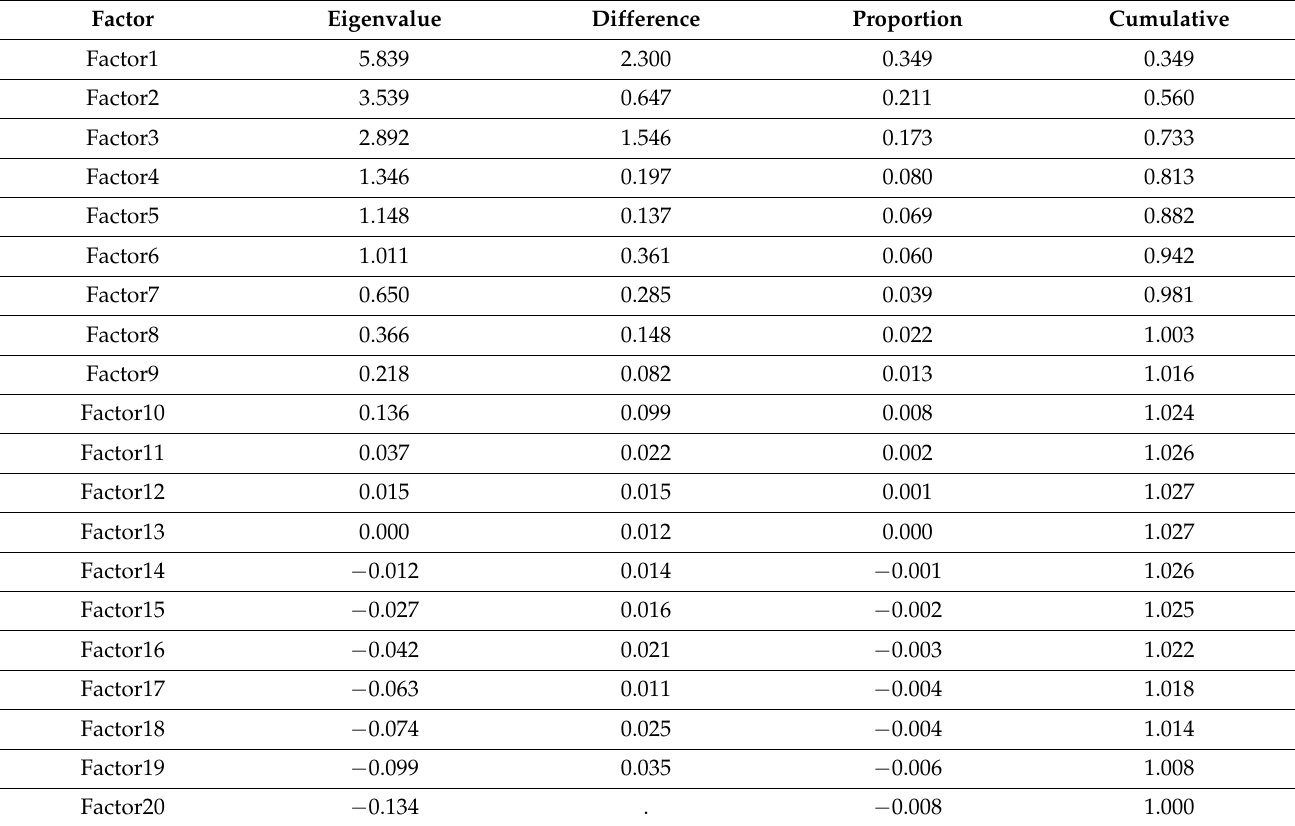
Table 2. The results of factorial analysis of the main components for estimating the three main factors.